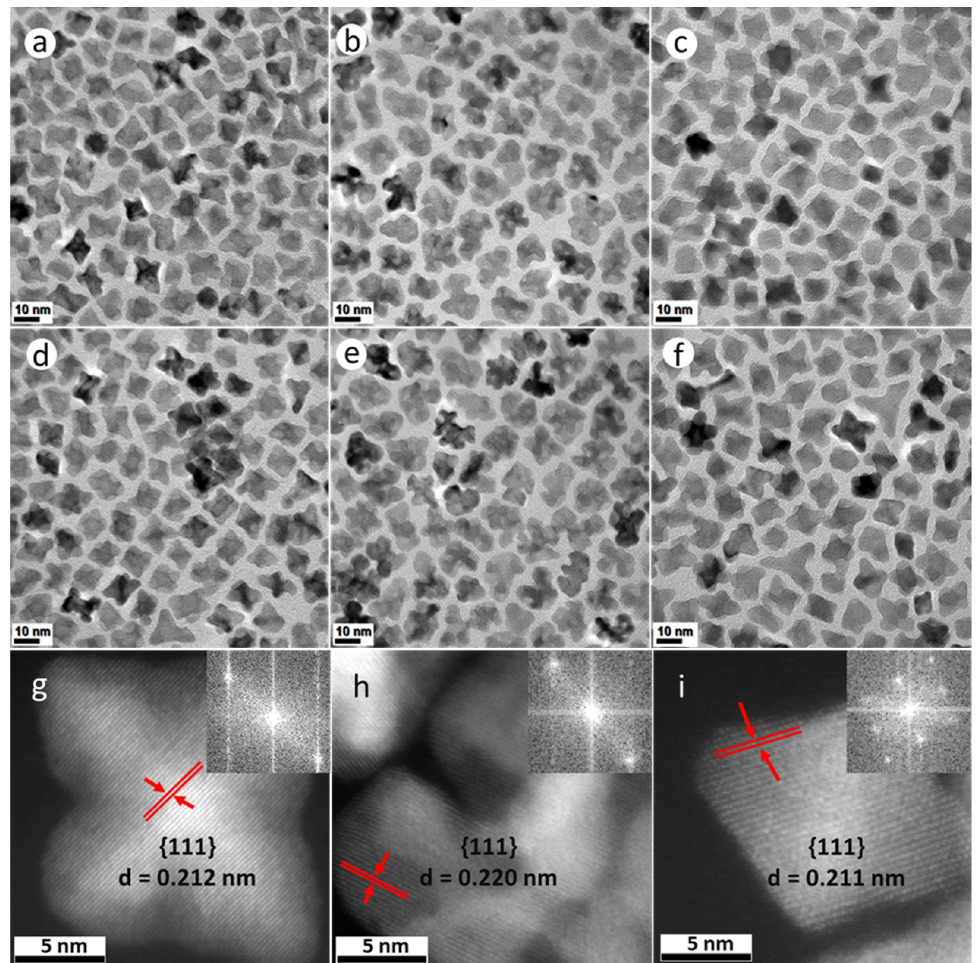
Figure 1. TEM bright field (BF) images of ( a – f ) PtNi, PtCo and Pt(NiCo) alloy NPs show insignificant morphological and size changes after the first measurement interval of 15 min ( a – c ) and the last 60 min ( d – f ). ( g , h ) Atomic-scale HAADF-STEM images of ( g ) PtNi, ( h ) PtCo and ( i ) Pt(NiCo) alloy NPs with good crystallinity and well-resolved lattice fringes confirming individual particles as perfect single crystals (insets are the assigned major facets, the calculated lattice spacings and FFT diffrac- tograms).